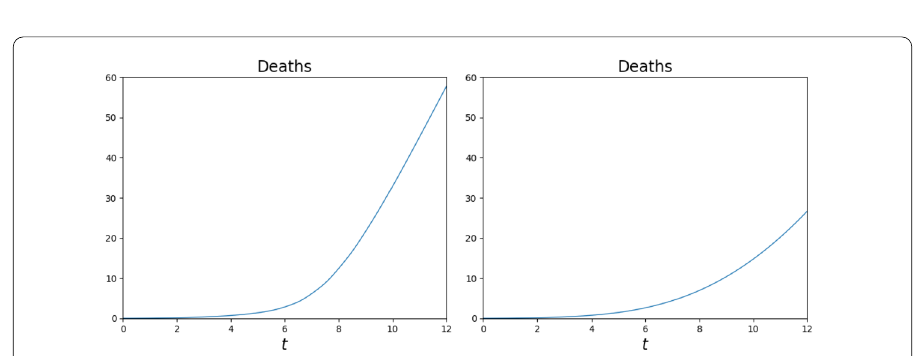
Figure 19 Numbers of deaths due to the virus, as a function of time, according to the solution to (8) in 12 days. The daily workers’ movements double the number of